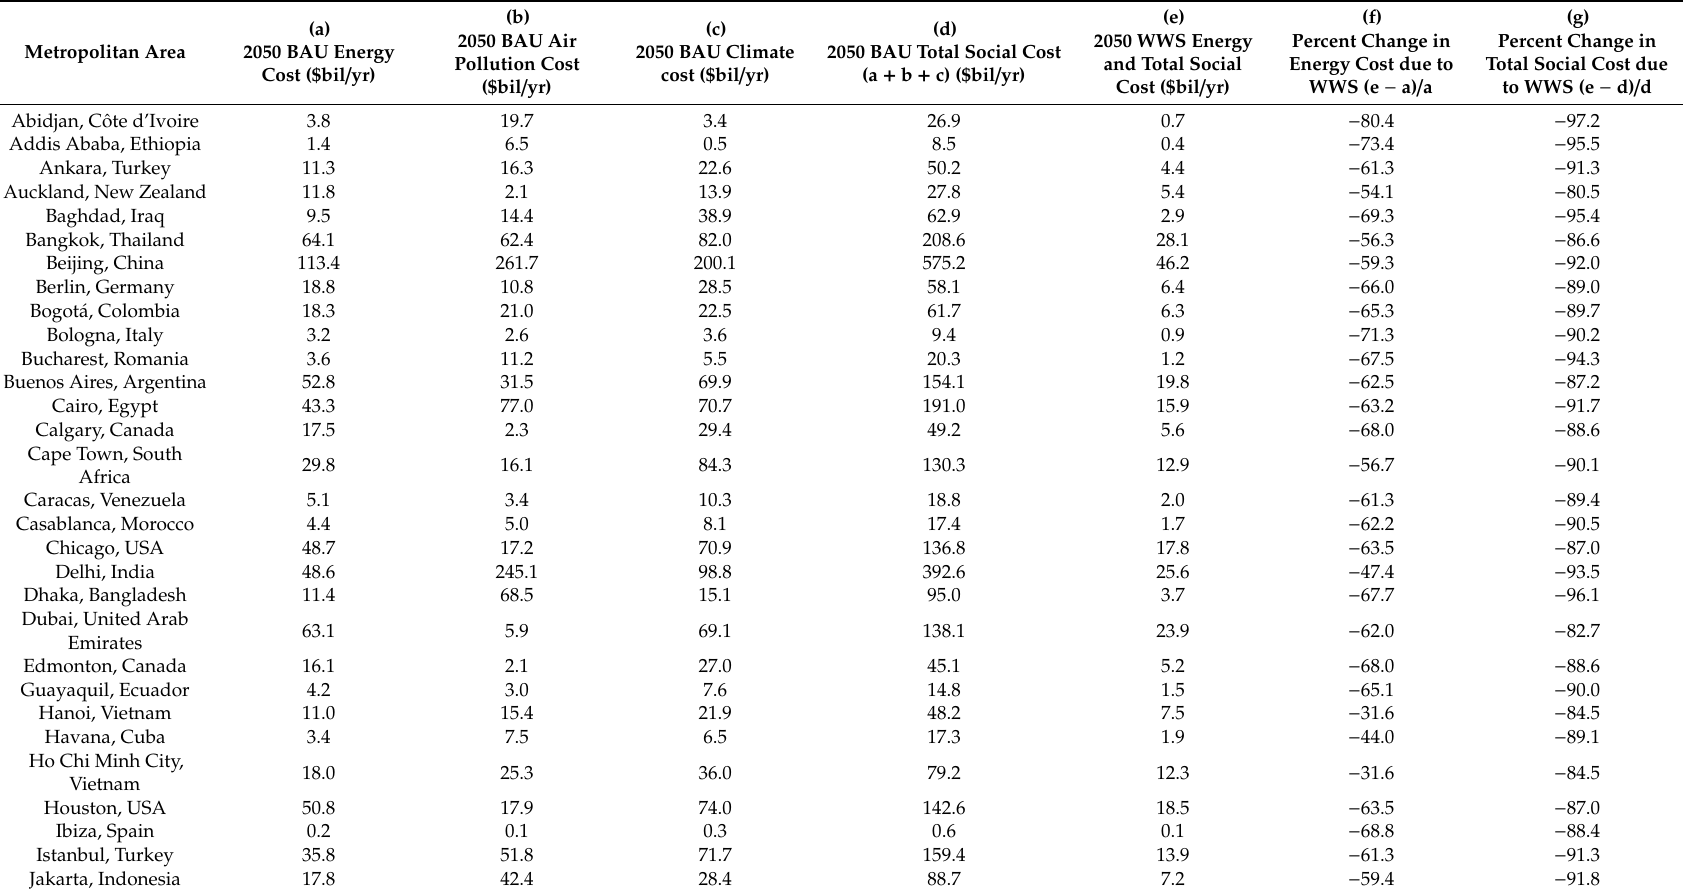
Table 8. ( a ) BAU annual energy cost, ( b ) BAU annual air pollution cost (from mortalities, morbidities, and non-air pollution e ff ects) due to energy, ( c ) BAU annual climate cost due to energy, ( d ) BAU annual total social (energy + air pollution + climate) cost, ( e ) WWS annual social cost ( = energy cost), and percent reduction in ( f ) energy cost and ( g ) social cost due to transitioning from WWS to BAU. All costs are in 2013 USD.